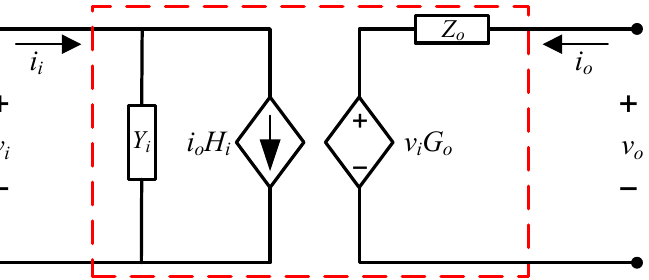
Figure 2. Two-port network model based on g-parameters for dc–dc power electronic converter (PEC).